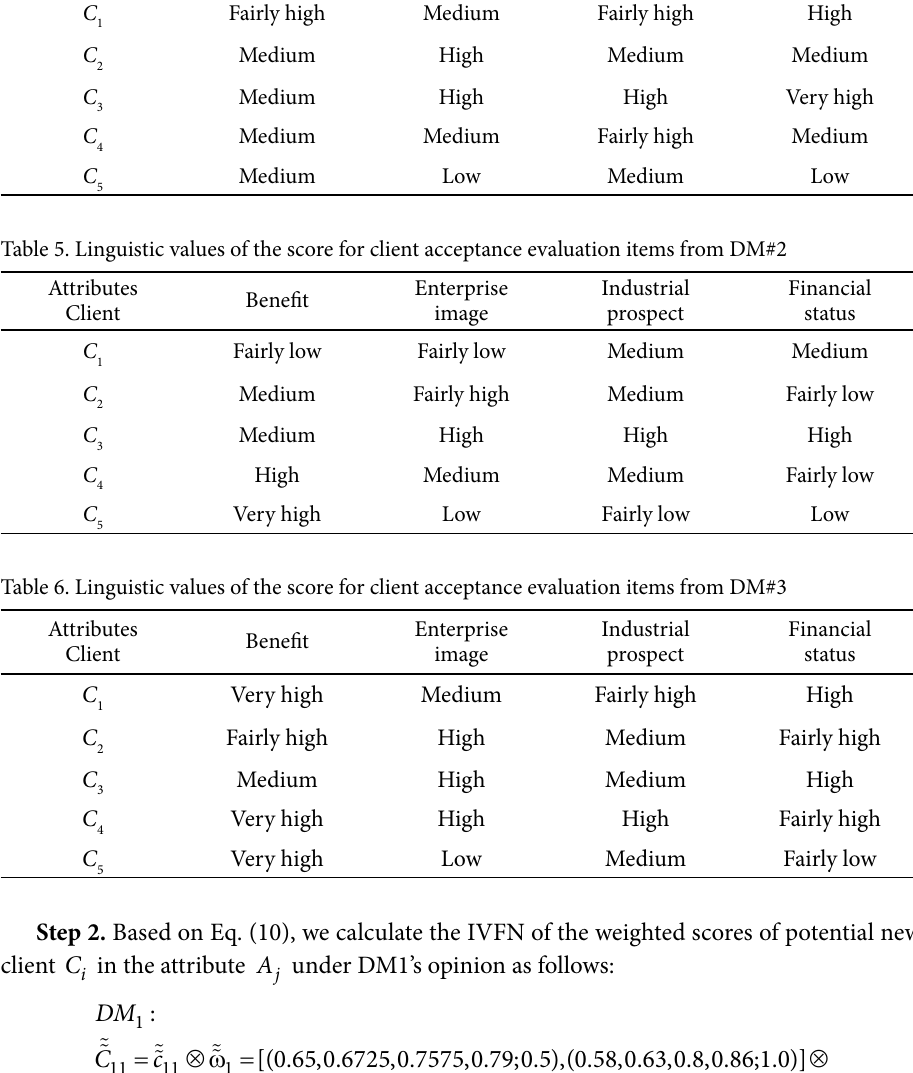
Table 4. Linguistic values of the score for client acceptance evaluation items from DM#1 Attributes Client